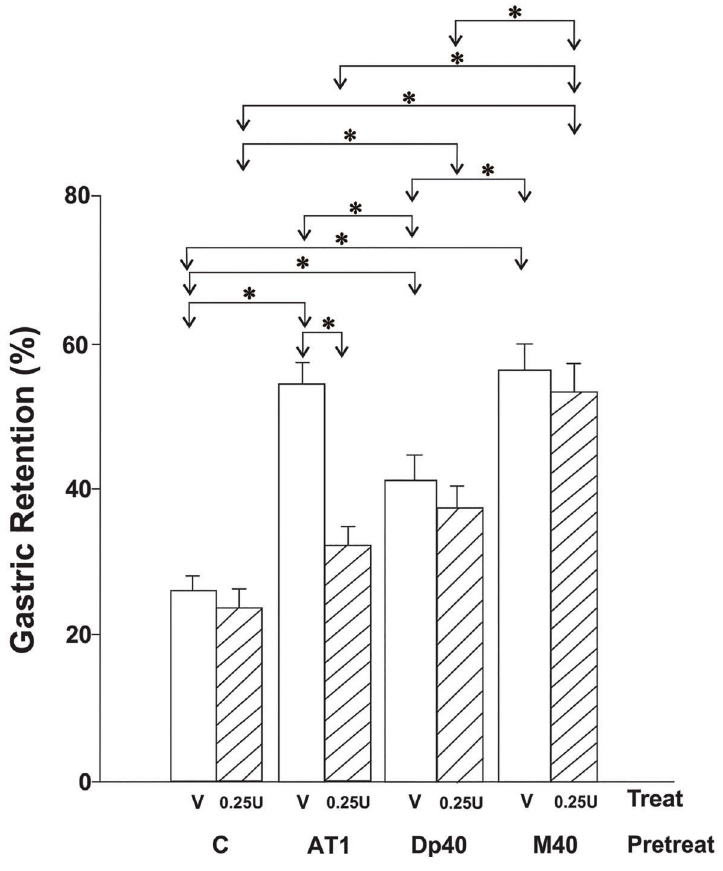
Figure 2. Gastric retention of a saline test meal (2 mL/100 g animal weight), 10 min after administration by gavage to rats. The animals were pretreated (Pretreat) iv with saline (C), 1 mg/kg atropine sulfate (AT1), 40 mg/kg dipyrone (Dp40), or a mixture of 1 mg atropine + 40 mg/kg dipyrone (M40), and after 30 min, treated (Treat) iv with vehicle (V) or 0.25 U/kg insulin (0.25U). The test meal was administered 30 min after treatment. Data are reported as means ± SE for 10 animals per group. *P o 0.05 (ANOVA fol- lowed by Tukey